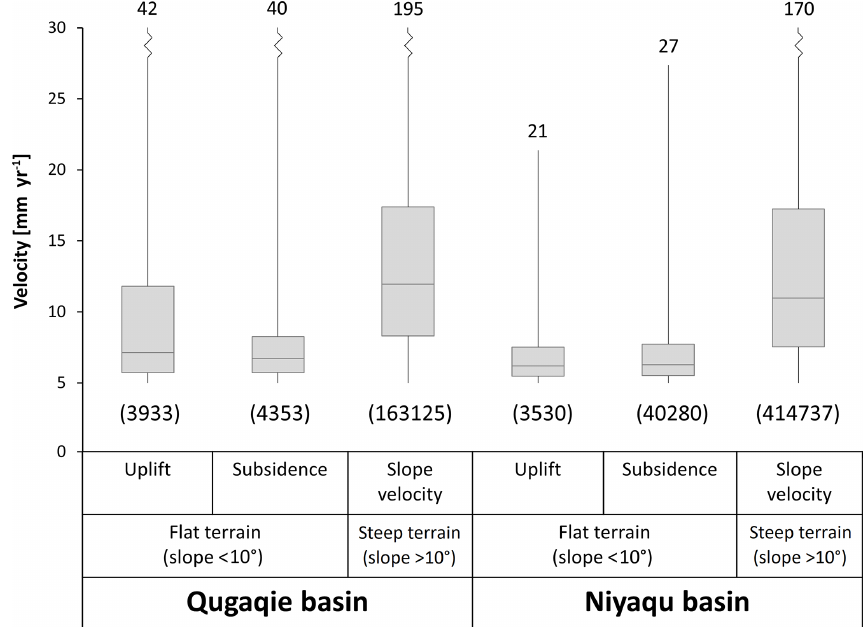
Figure 2. Distribution of the mean velocity results of the LVM for unstable flat and steep terrain in both study areas. All surface motion in flat areas (slope < 10 ◦ ) was projected into the vertical direction (uplift and subsidence), and motion in steeper areas was projected along the direction of the slope. The maximum values are shown above the respective boxplots and the number of data points included in each plot is shown in parentheses below them. Areas with velocities < 5mmyr − 1 are considered stable and are not shown here. Table 3. Summary of the spatial data coverage of the LVM in the study areas. The values represent the percentages compared to all flat or steep terrain in the respective study area. Incoherent areas display a mean coherence of < 0.3. Stable areas are characterized by multiannual velocities < 5mmyr − 1 in all directions. Unstable flat areas move at > 5mmyr − 1 and are divided into uplift, subsidence and horizontal mo- tion (uplift/subsidence/horizontal). Steep unstable areas move at > 5mmyr − 1 downslope and very unstable terrain moves at > 30mmyr − 1 . Terrain Incoherent